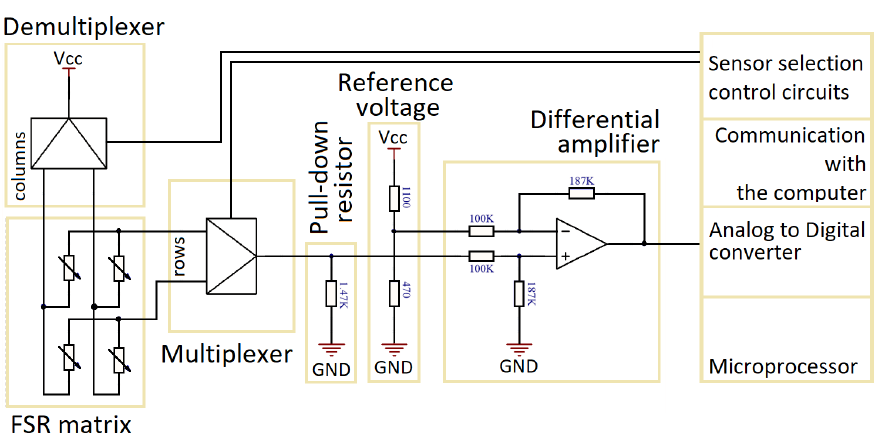
Figure 2. Block diagram of the electronic system for determining the localisation and a value of touch pressure exerted on the FSR matrix.